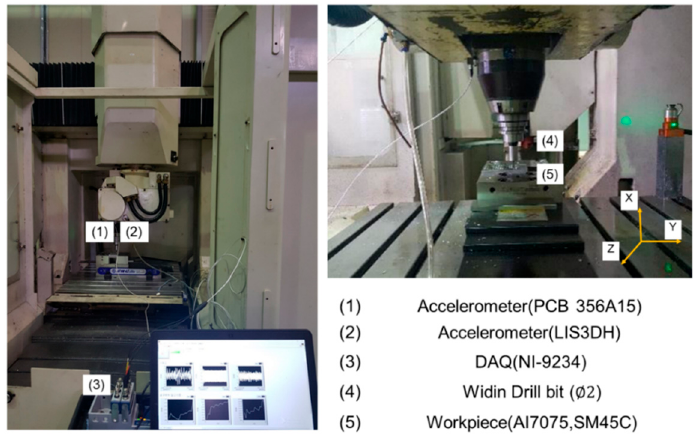
Figure 4. Machining experiment set up.